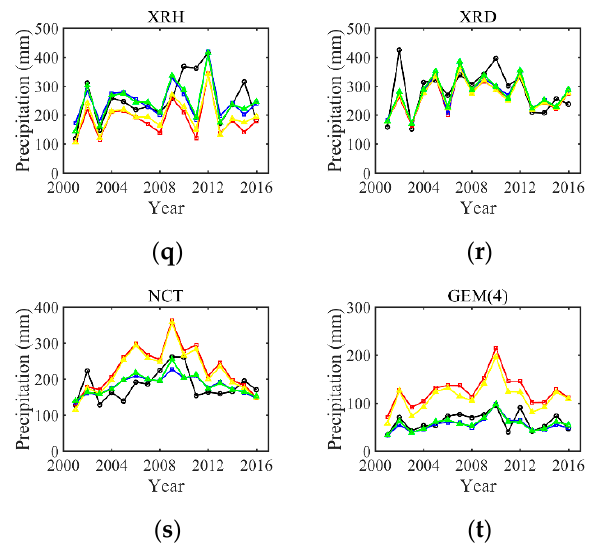
Figure 8. The annual precipitation time series of the gauged precipitation, original and corrected of 3B42RT and 3B43 products at the 20 gauge stations. ( a ) DCD: DaChaDan; ( b ) DLH: DeLingHa; ( c ) DL: